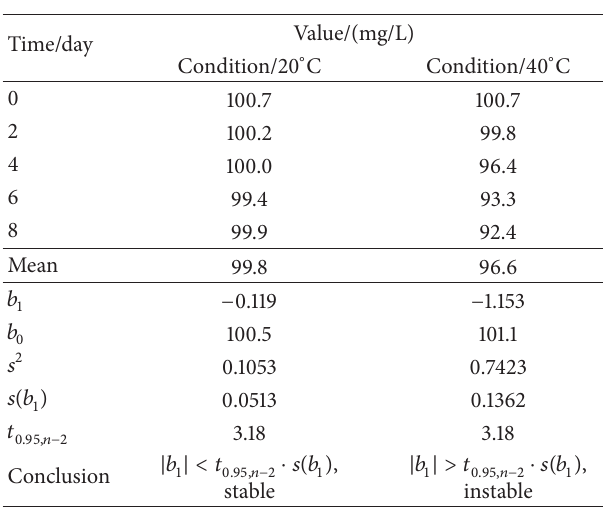
Table 5: Result of short-term stability